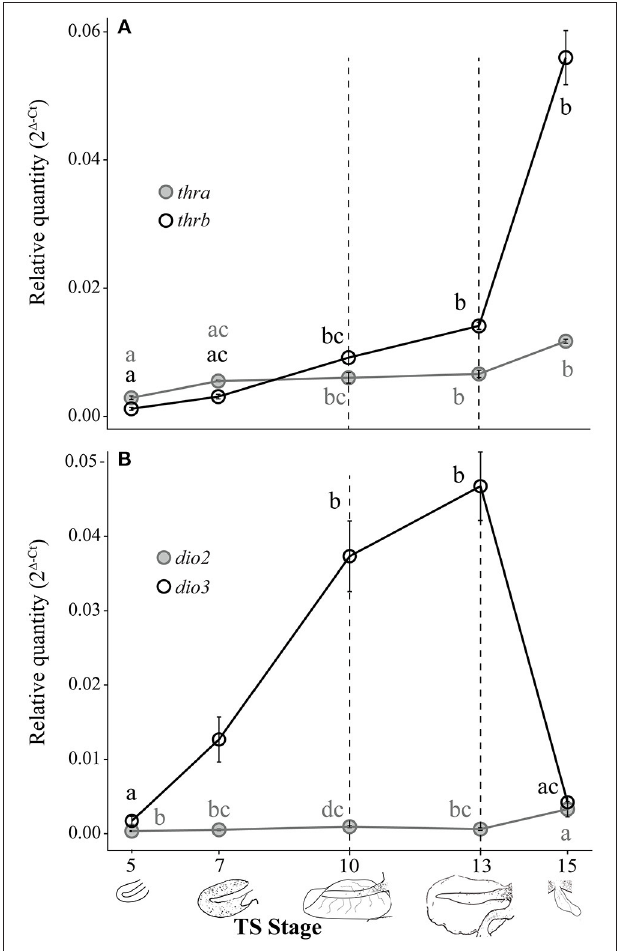
FIGURE 3 | Relative thra and thrb mRNA levels (A) and dio2 and dio3 mRNA levels (B) in the pre-hatching tail of E. coqui . Dashed vertical line at TS stage 10 marks when thyroid follicles are first visible in histological sections; the line at TS 13 indicates the onset of tail resorption. Drawings on the x-axis depict tail growth and resorption before hatching. Each expression value is represented as a circle centered on the mean of 3–7 individuals ± SE. Lower-case letters in gray ( thra and dio2 ) and black ( thrb and dio3 ) indicate significant pairwise differences between groups ( post-hoc Dunn’s test, p < 0.05). See Supplementary Data for a complete list of pairwise comparisons.